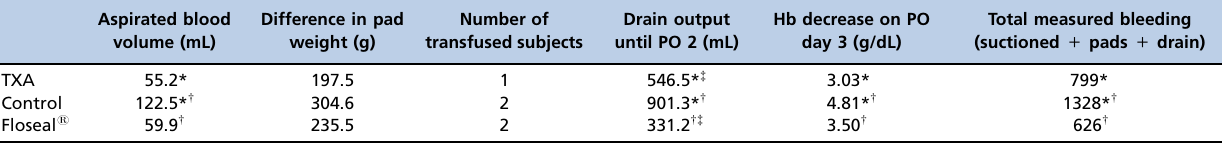
Table 3 - Mean values of the investigated variables related to blood